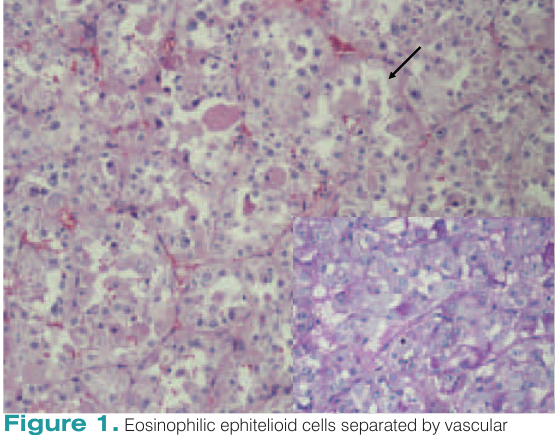
Figure 1 . Eosinophilic ephitelioid cells separated by vascular channels making the typical alveolar pattern of ASPS (H-E 100X). In botton,cytoplasmic eosinophilic and granular material (PAS 200X). Note the absence of PAS-positive crystals in the cytoplasm.